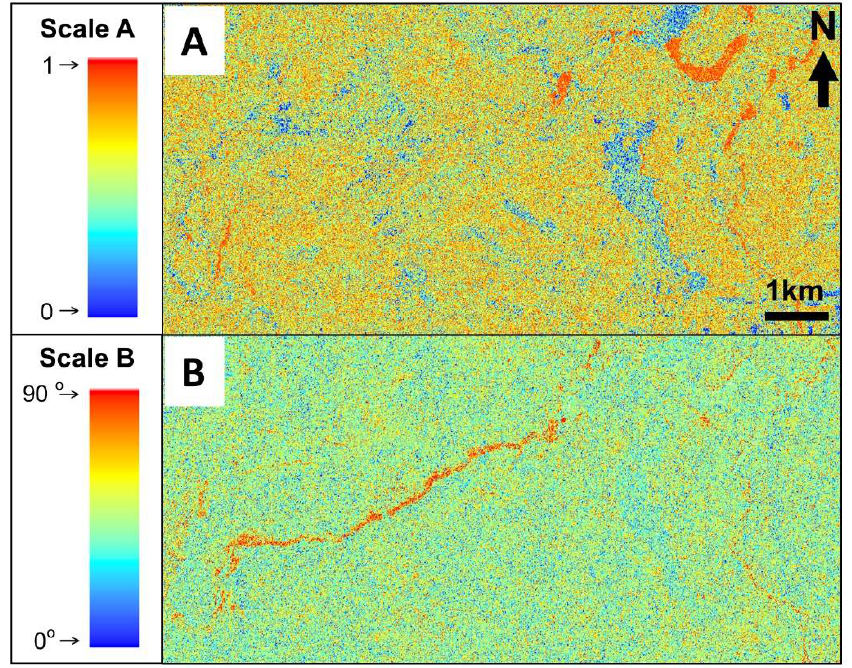
Figure 4. Images of parameters entropy ( A ) and alpha ( B ) for the TerraSAR-X scene from 2 April 2016.